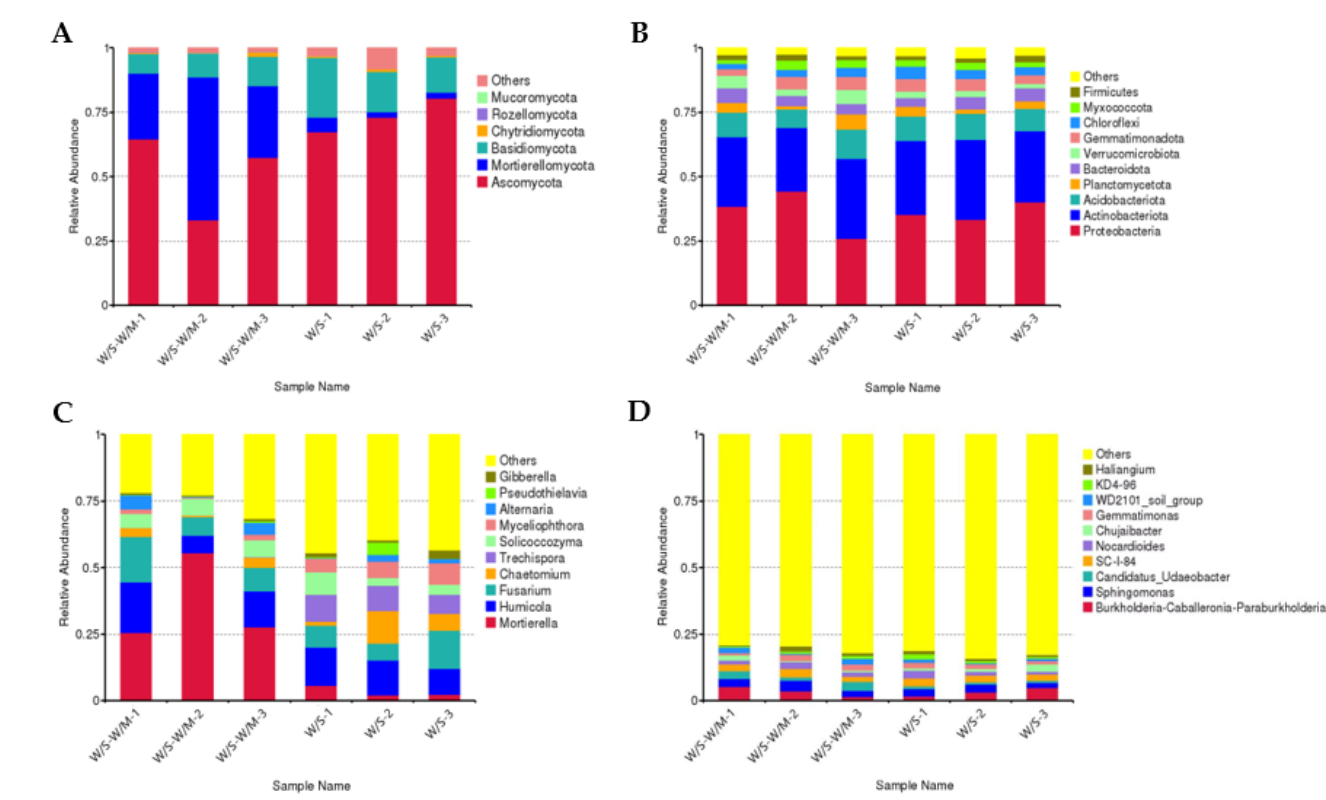
Figure 2. The fungal and bacterial community composition in the rhizosphere soil. ( A , B ): The relative abundance of fungi ( A ) and bacteria ( B ) between the W/S-W/M and W/S at the phylum level. ( C , D ): The relative abundance of fungi ( C ) and bacteria ( D ) between the W/S-W/M and W/S at the genus level. W/S-W/M-1, W/S-W/M-2, and W/S-W/M-3 represent the three replications of W/S-W/S treatment. W/S -1, W/S-2, and W/S-3 represent the three replications of W/S